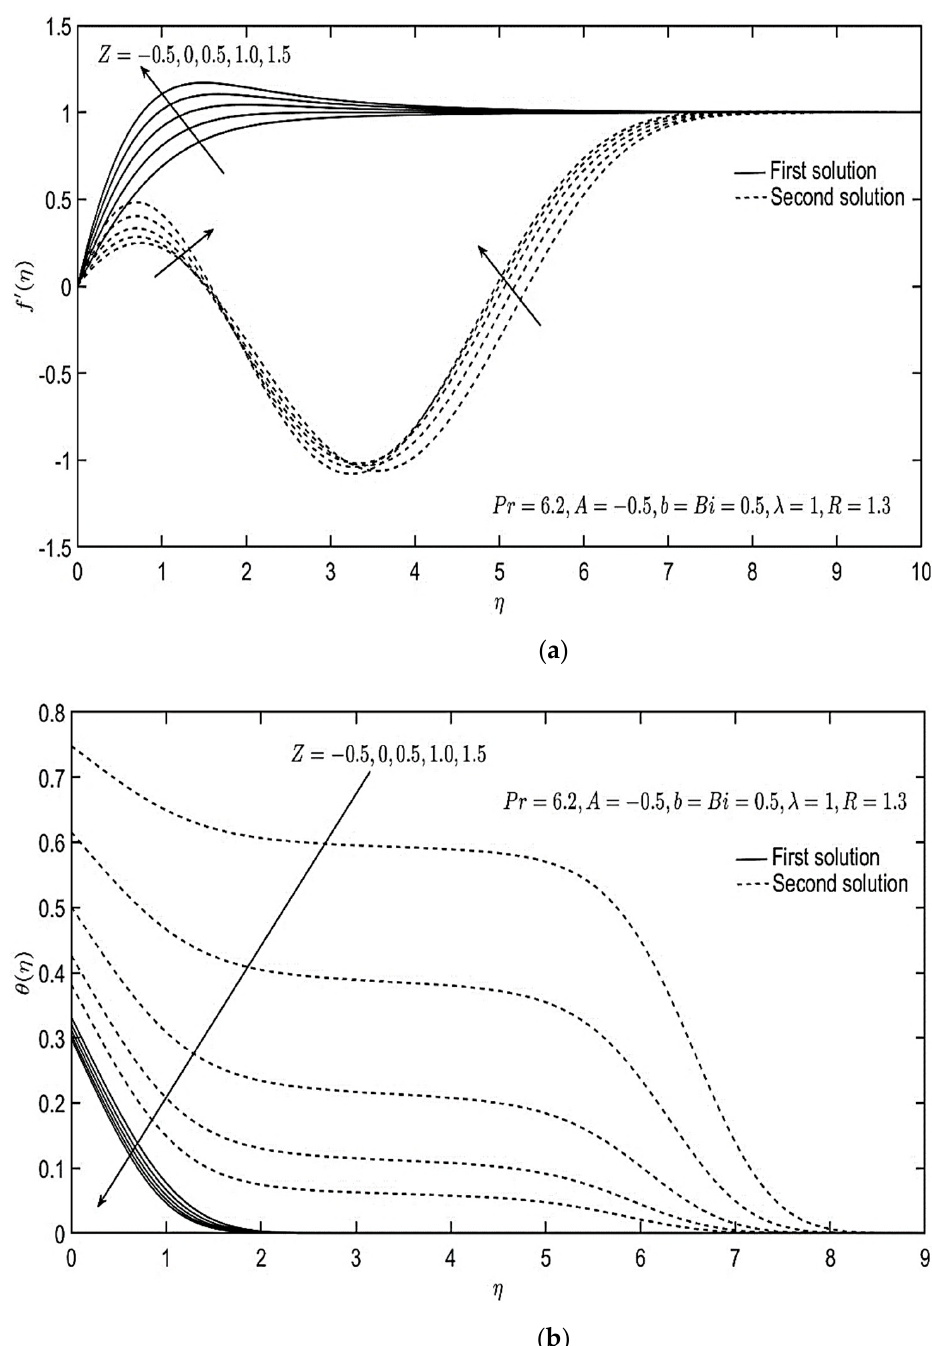
Figure 7. ( a ) Velocity and ( b ) temperature distributions for various values of 𝑍 .